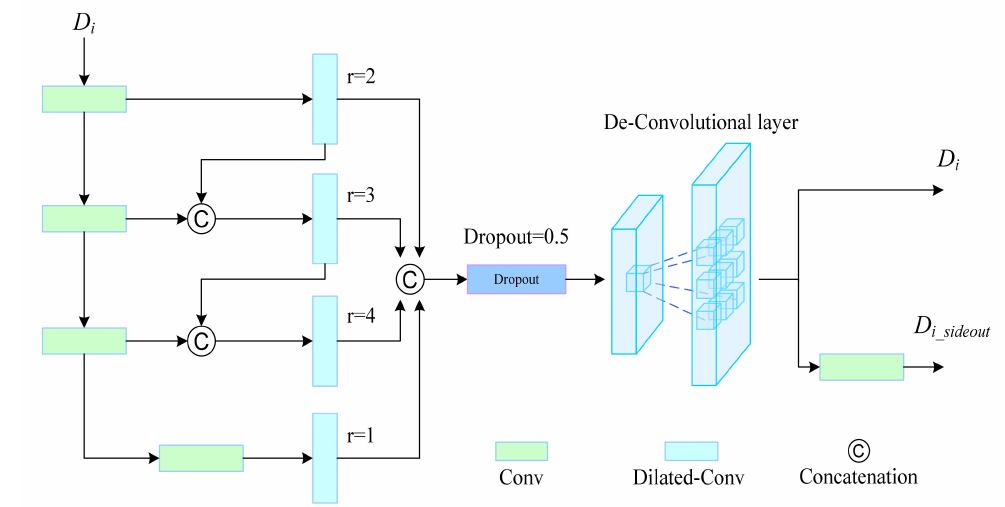
Figure 2. Architecture of the proposed